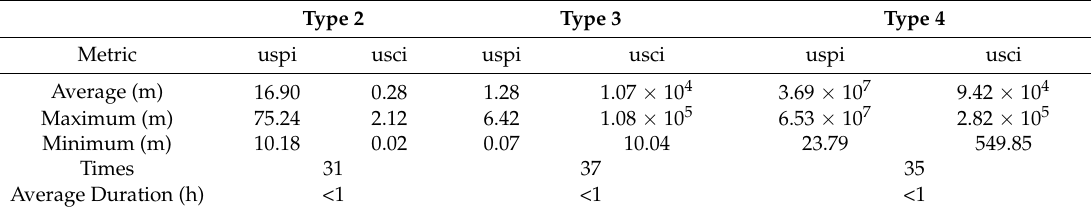
Table 3. Statistics of different types for unhealthy states lasting less than one